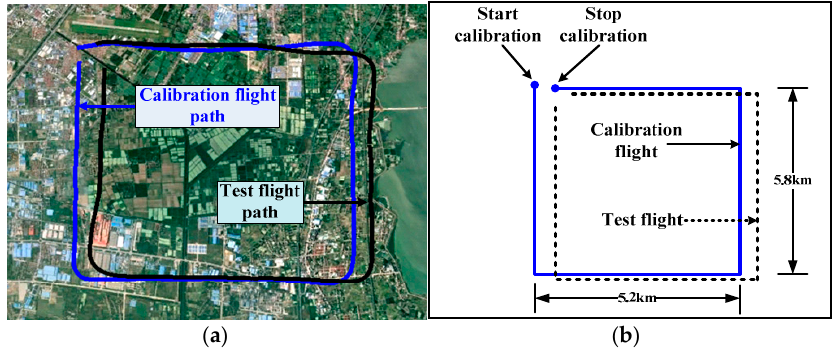
Figure 3. Calibration and test flight path in google earth ( a ) and its scale drawing ( b ).